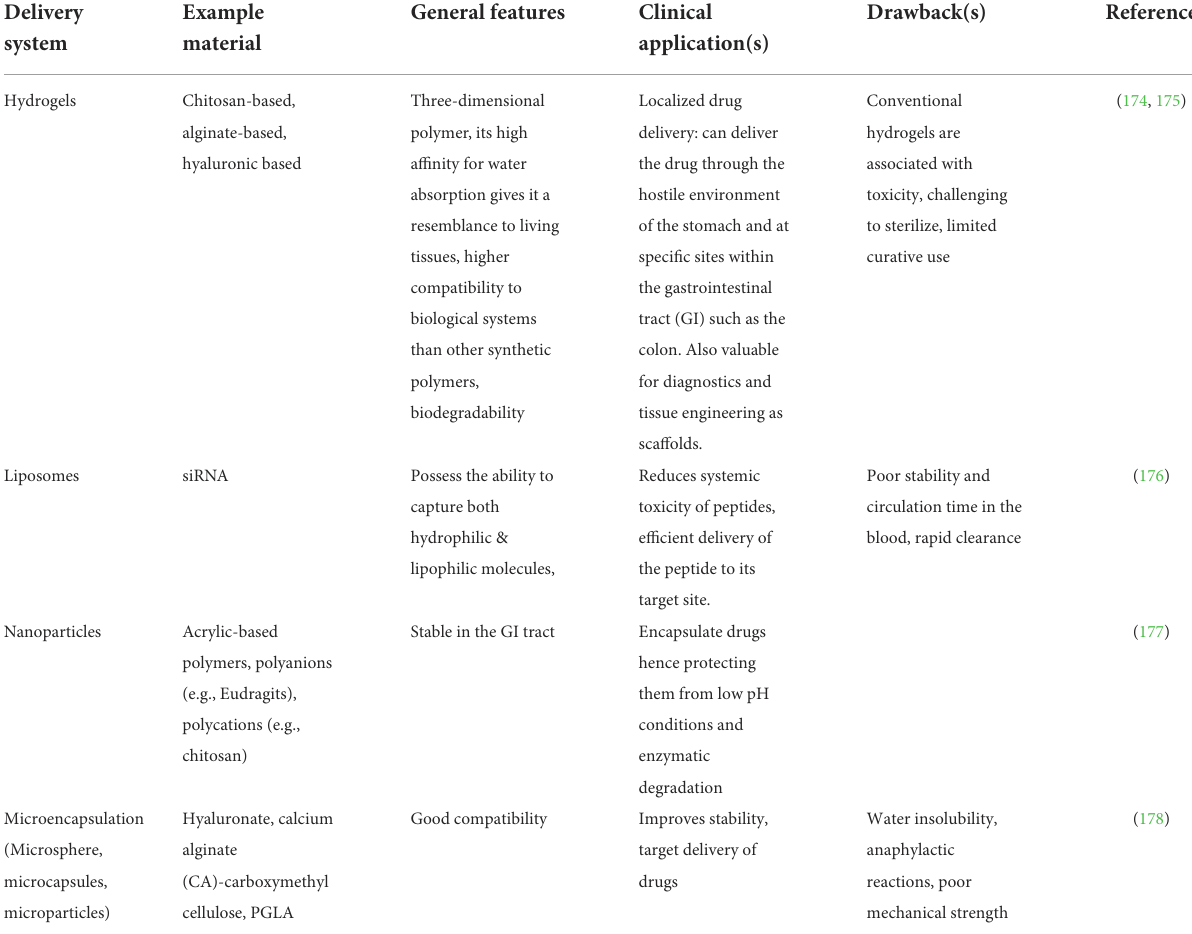
TABLE 5 Examples of controlled delivery systems for bioactive